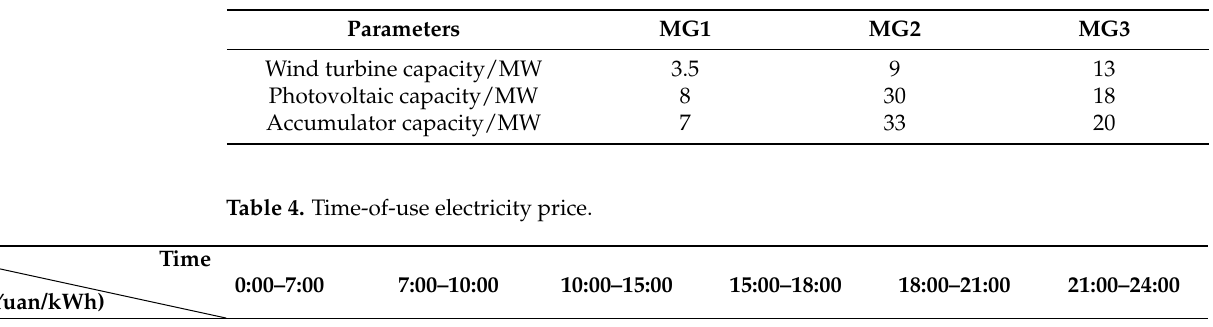
Table 3. Microgrid configuration parameters.